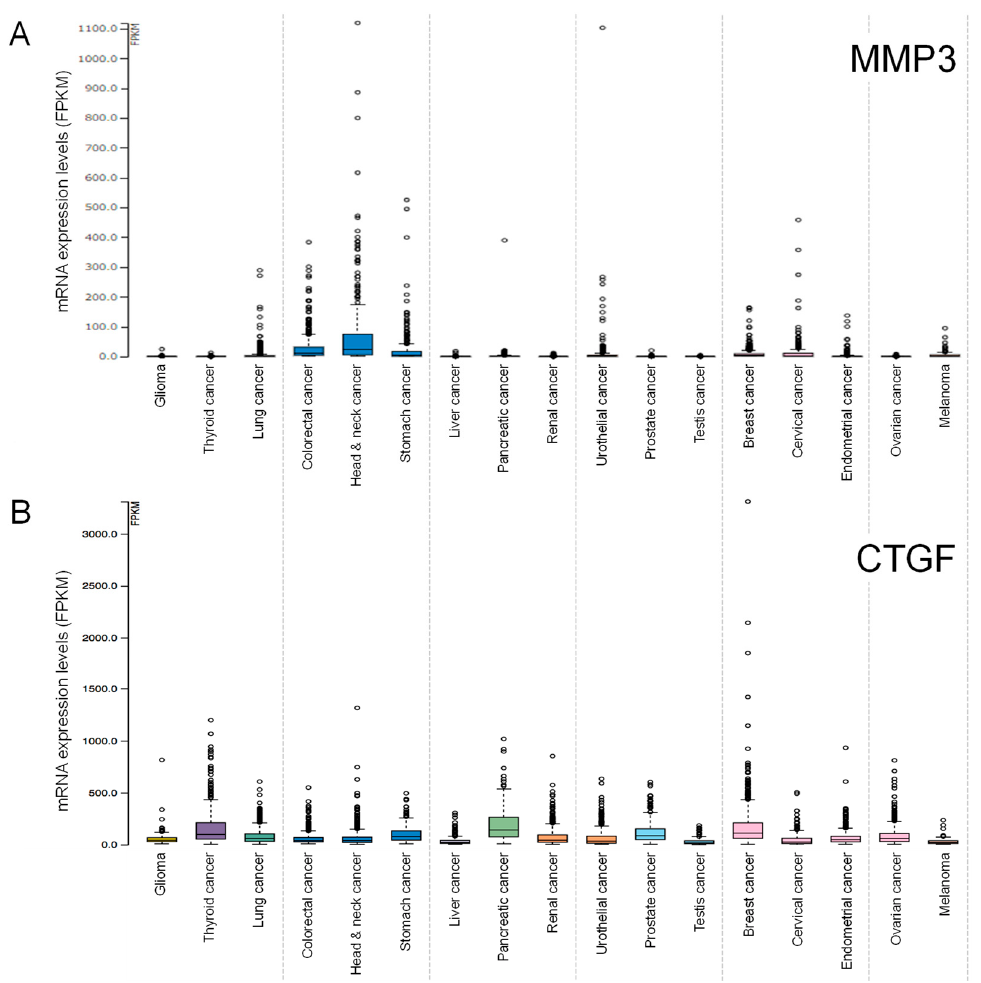
Figure 8. Figure 8. Expression levels of ( A ) MMP3 and ( B ) CCN2 / CTGF mRNA in patient-derived tumor specimens. Values indicate fragments per kilobase per million mapped reads (FPKM) of RNA-seq. Data were obtained from TCGA and Human Protein Atlas